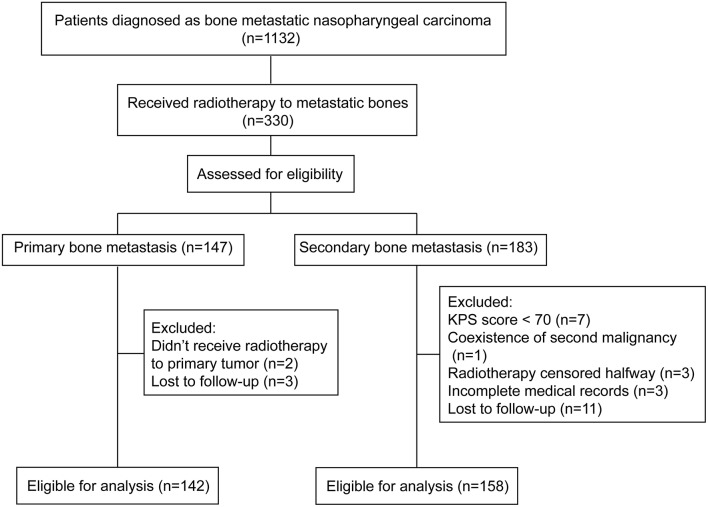
Flow diagram of study selection process. Inclusion and exclusion criteria.